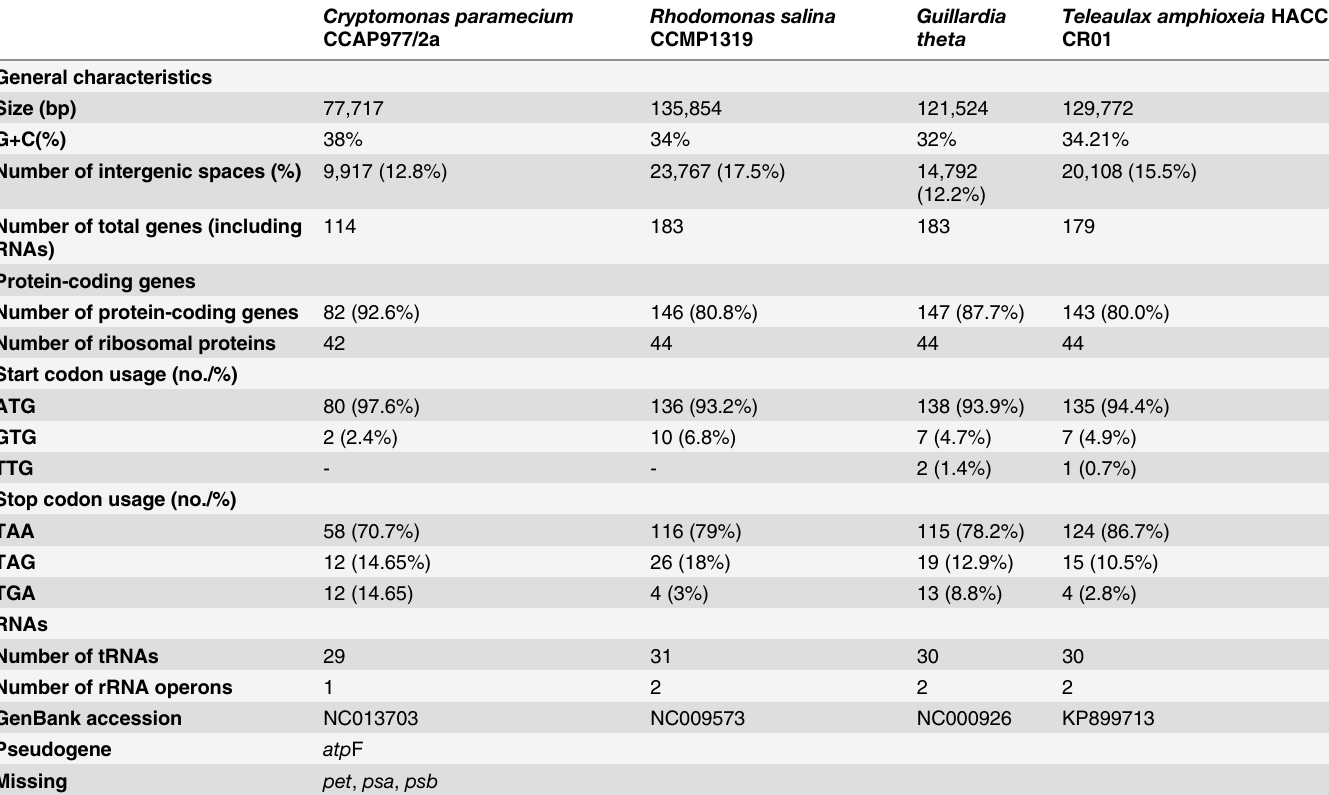
Table 1. Characteristics of the cryptophyte plastid genome analyzed in this